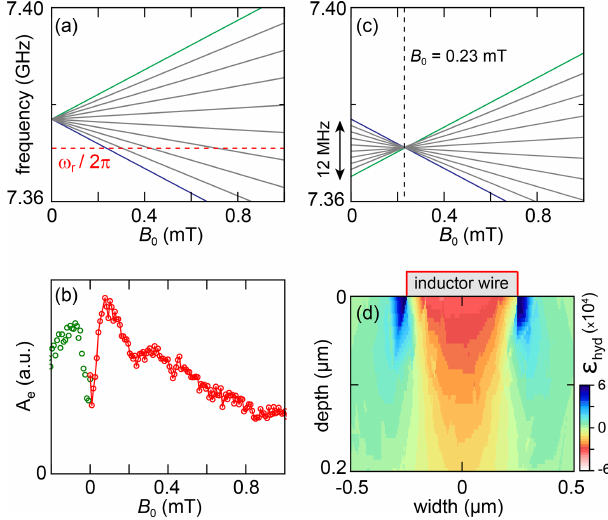
Figure 8. (a) EPR-allowed transitions of a bismuth donor in silicon for 0 < B 0 < 1mT. The dashed red line denotes the resonator fre- quency ω r . The spectrum is for an unstrained donor for which the frequency at B 0 = 0 is 5 A Bi / (2 π ). (b) Echo-detected field sweep. The echo integral A e is plotted versus B 0 . (c) Frequency of all 18 bismuth donor transitions that may contribute to the echo signal at a given field (here, B 0 = 0 . 23mT). This is made possible by the strain-induced spread in A Bi between different donors. (d) Hydro- static component of strain in silicon simulated using COMSOL.